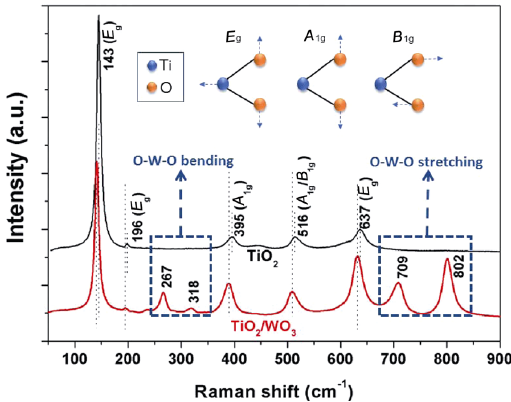
Fig. 4 Raman spectra of pure TiO 2 and TiO 2 /WO 3 nanostructures sintered at 500 ℃ . In the inset, E g , A 1g , and B 1g vibrational motions of Ti and O atoms of TiO 2 are illustrated. The dotted lines help visualize the redshift of TiO 2 bands in sintered TiO 2 /WO 3